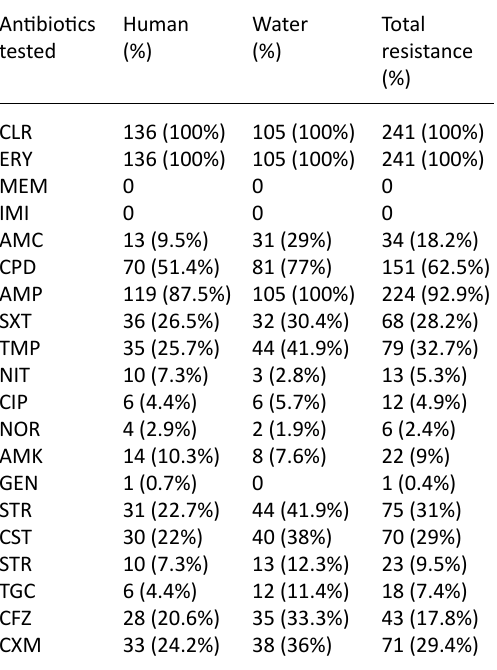
Table 4. Number of E. coli isolates resistant to selected